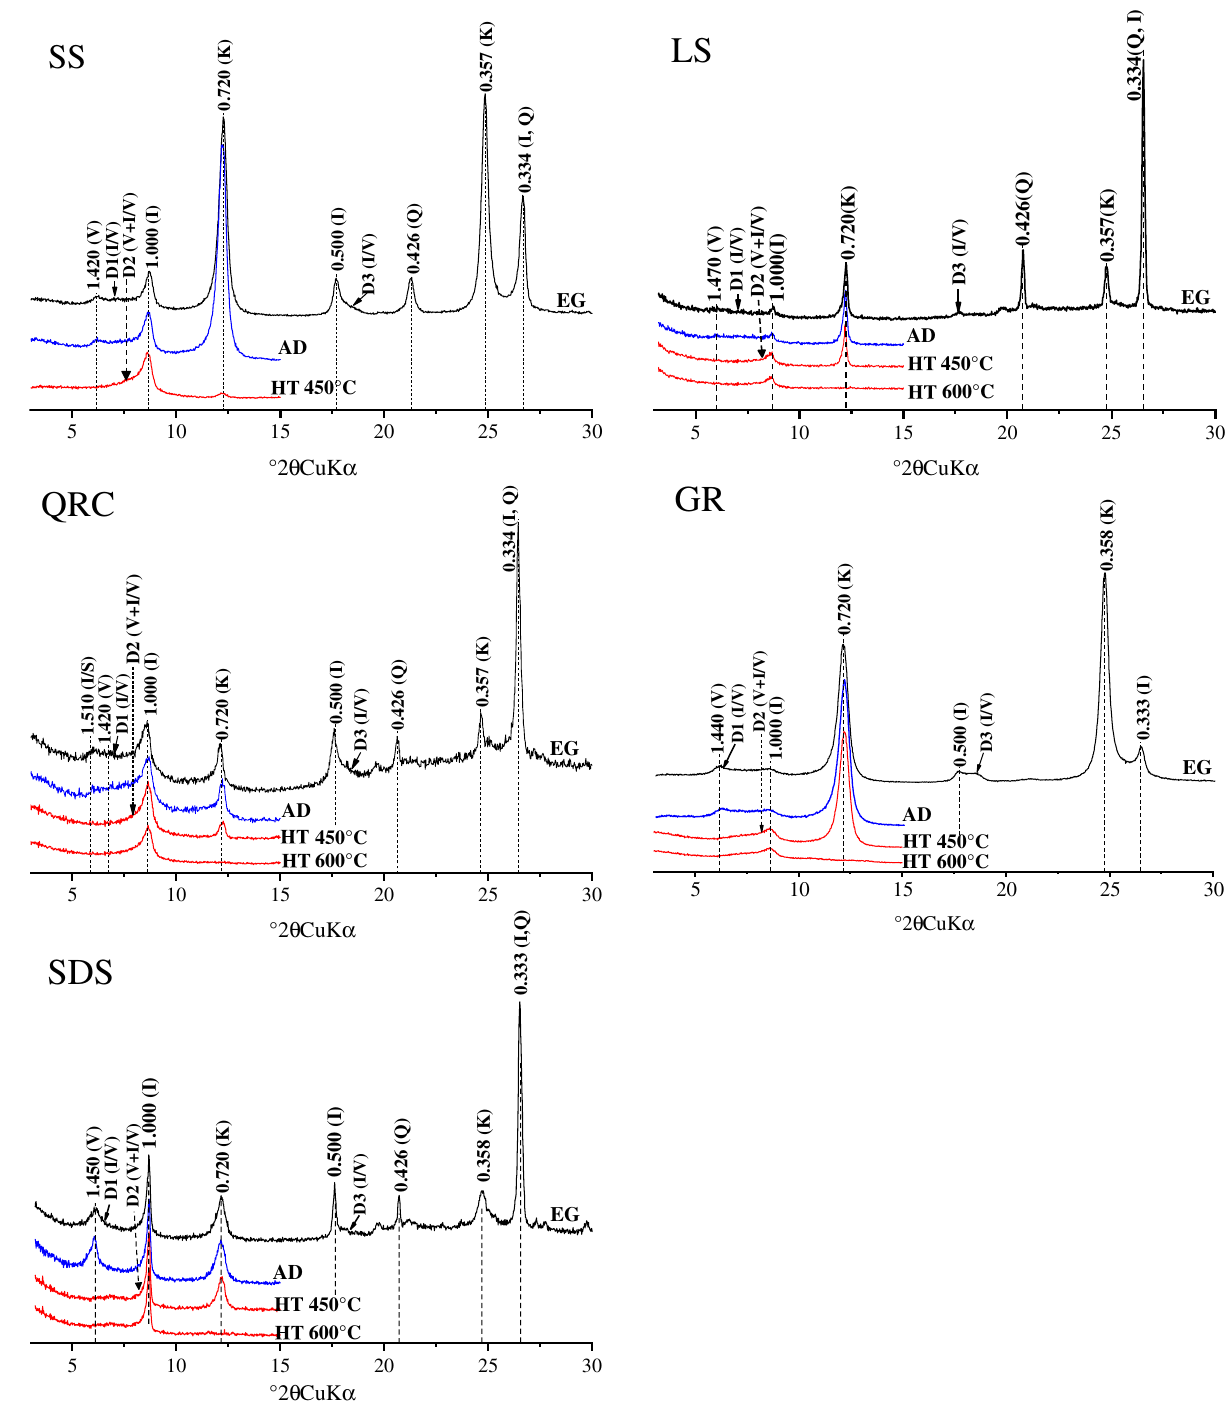
Figure 2. X-ray diffraction patterns of the representative upland soil profiles derived from different parent materials (K: kaolinite; I: illite; V: vermiculite; I/S: illite/smectite mixed-layer mineral; I/V: illite/vermiculite mixed-layer mineral; Q: quartz; AD: air-dried sample; EG: ethylene–glycol saturated sample; HT 450 °C: sample heated at 450 °C; HT 600 °C: sample heated at 600 °C; SS: slate and shale; LS: limestone; QRC: Quaternary red clay; GR: granite; SDS: